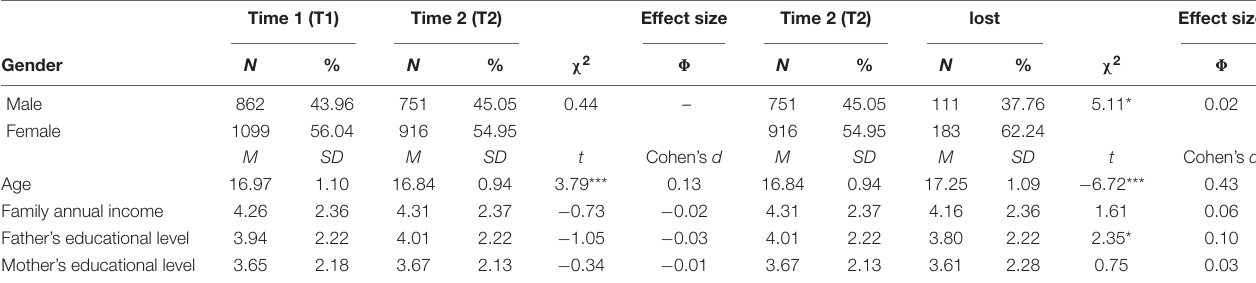
TABLE 1 | The differences for background variables between T1 and T2, as well as T2 and lost. Time 1 (T1) Time 2 (T2) Effect size Time 2 (T2) lost